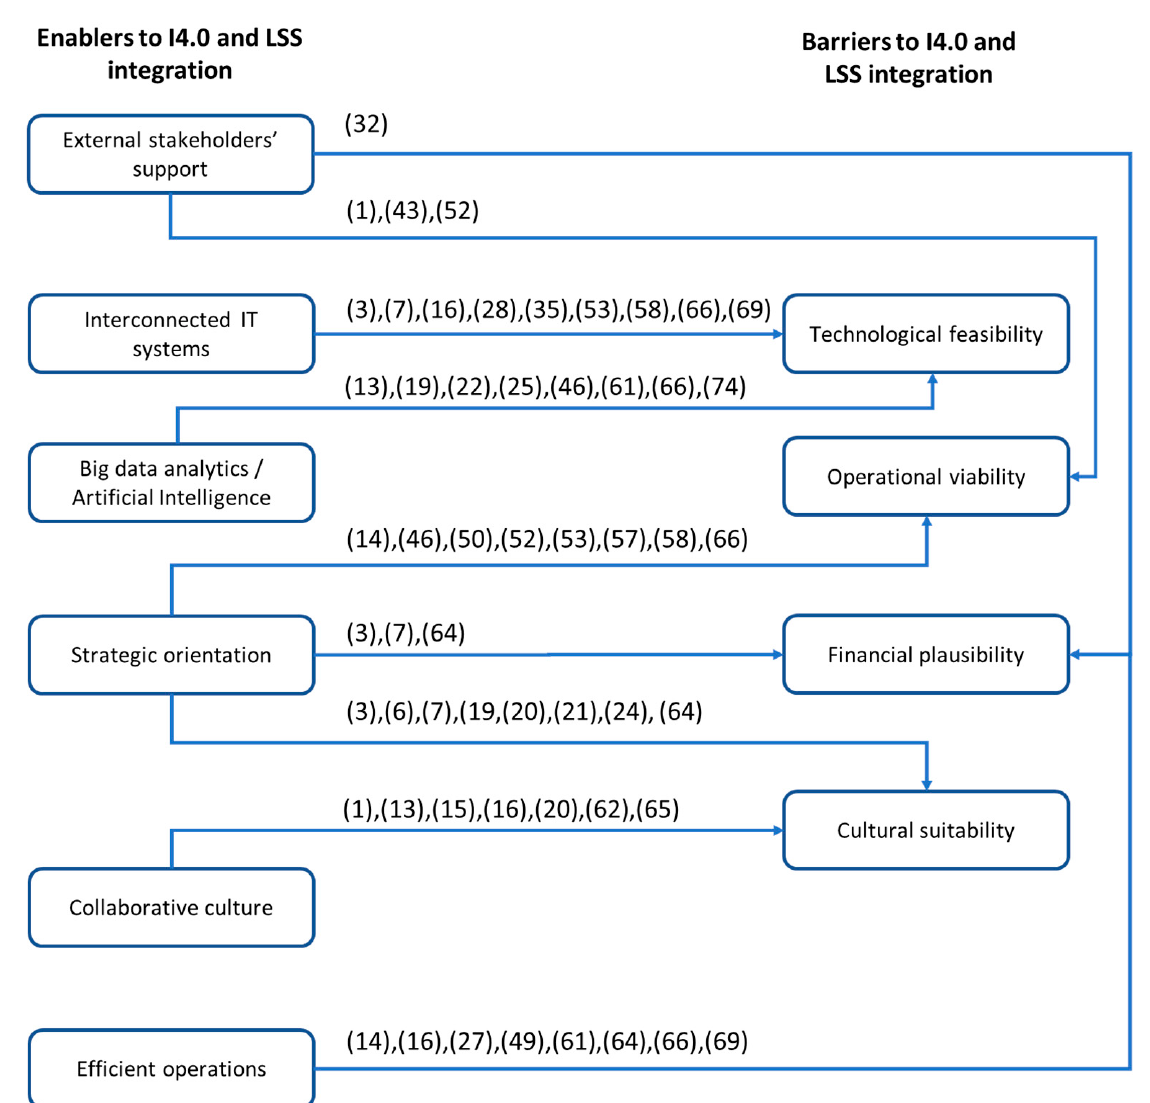
Figure 7. Connecting enablers to barriers for I4.0 and LSS integration (articles in Appendix A).